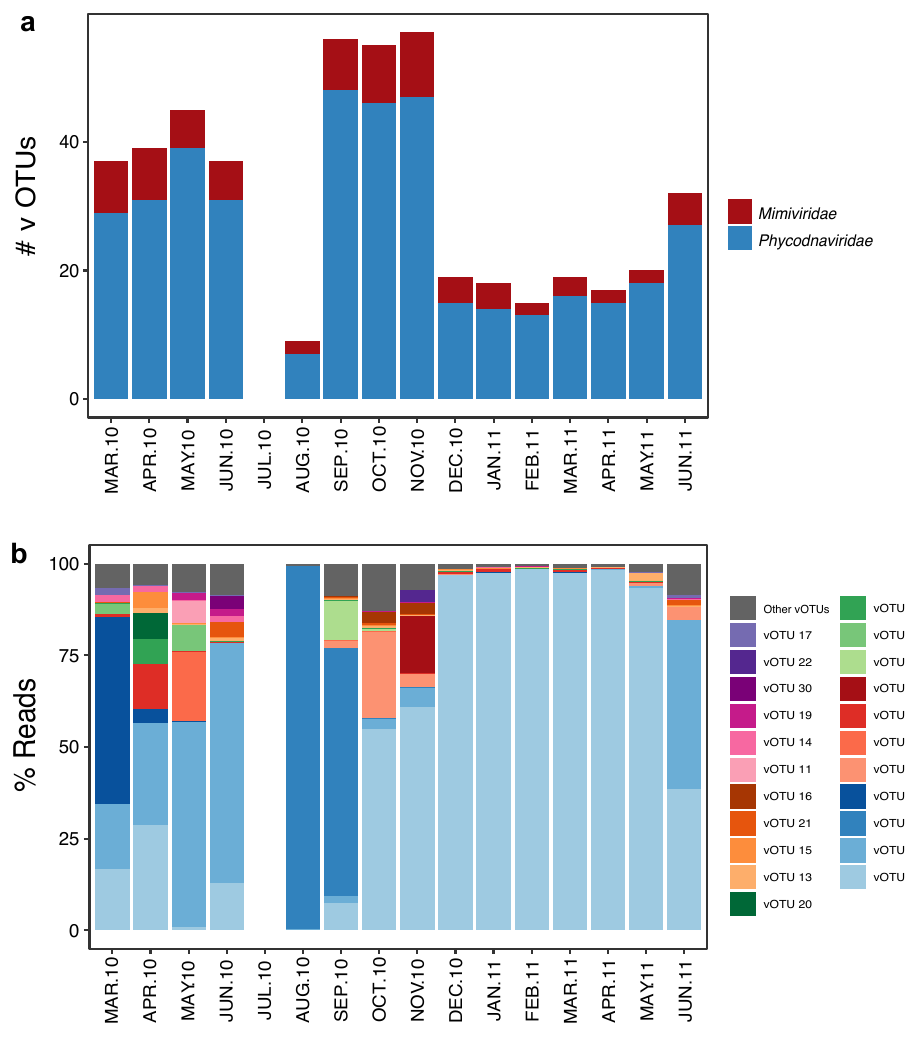
Figure 2. Barplots representing: ( a ) Number of vOTUs per family and ( b ) proportional abundance (percentage reads) of the most abundant vOTUs ( > 50 reads per vOTU) over time at Outer Oslofjorden